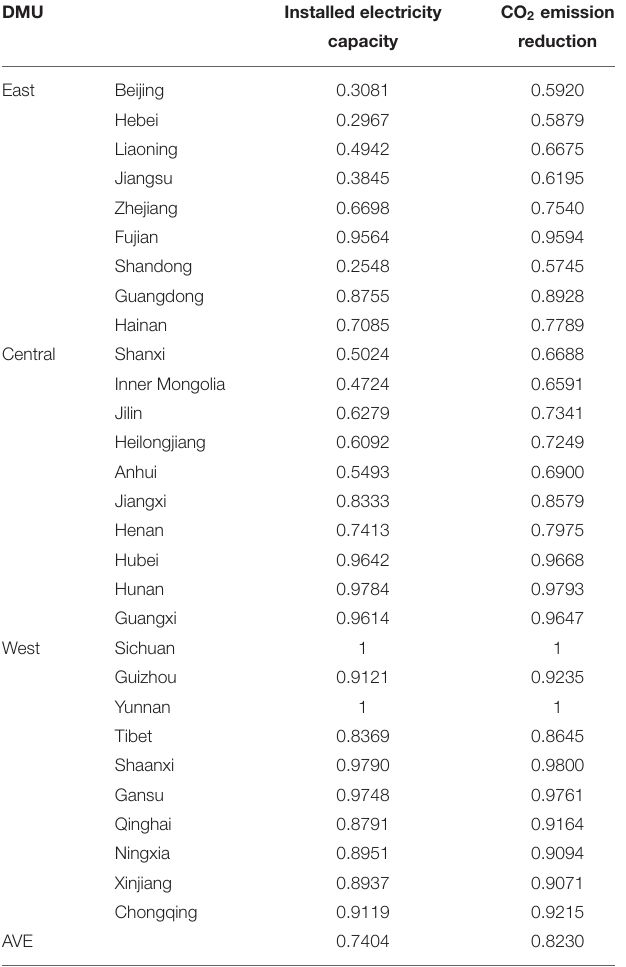
TABLE 4 | Average score of installed electricity capacity and CO 2 emission reduction efficiency. DMU